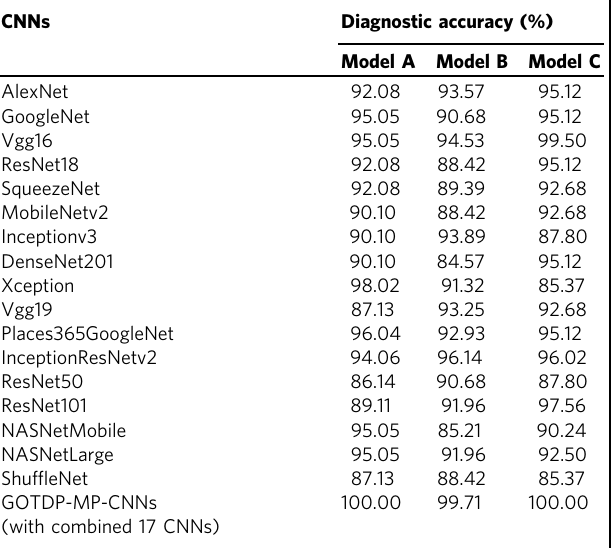
Table 1 Diagnostic accuracy of 17 CNNs for DLBCL.